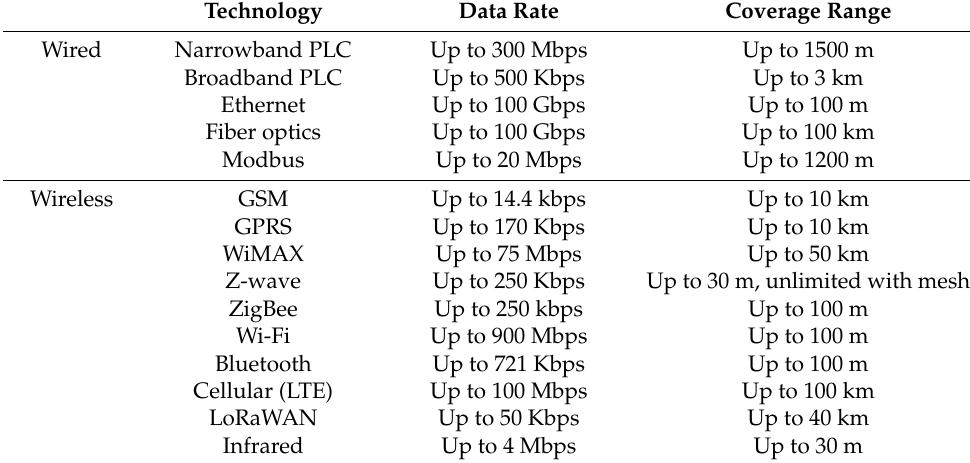
Table 4. Wireless and wired communication protocols for energy management [3,14,17,76–79].